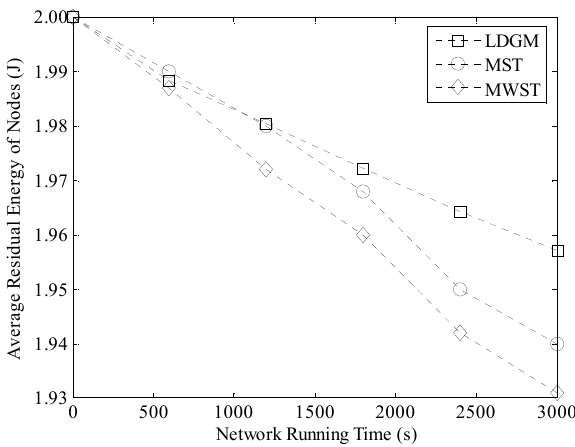
Figure 32. Average residual energy of nodes (100 m × 100 m, 200 nodes).